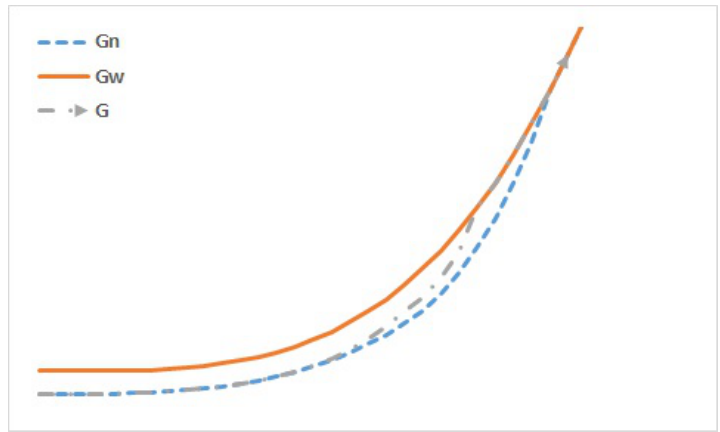
Figure 1. Supply side policy (i.e., a policy aimed at increasing the aggregate supply through investments, deregulation, liberalization, privatization, etc.) to raise the natural growth path. When G = G w < G n there is a permanent unemployment equilibrium. Policy-makers may employ supply side policies in order to increase both: the actual growth and G and the natural growth G n .